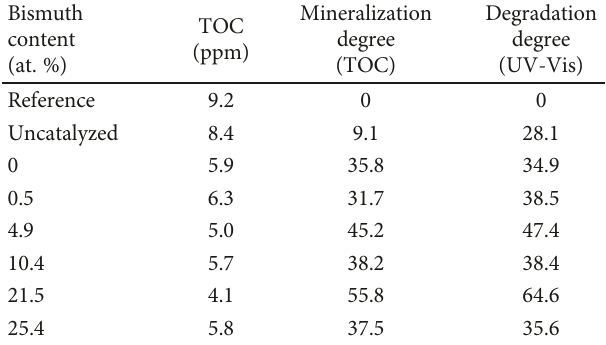
Figure 11: Photodegradation percent of MG dye using the Bi- modi fi ed TiO thin fi lms under solar simulated irradiation. 2